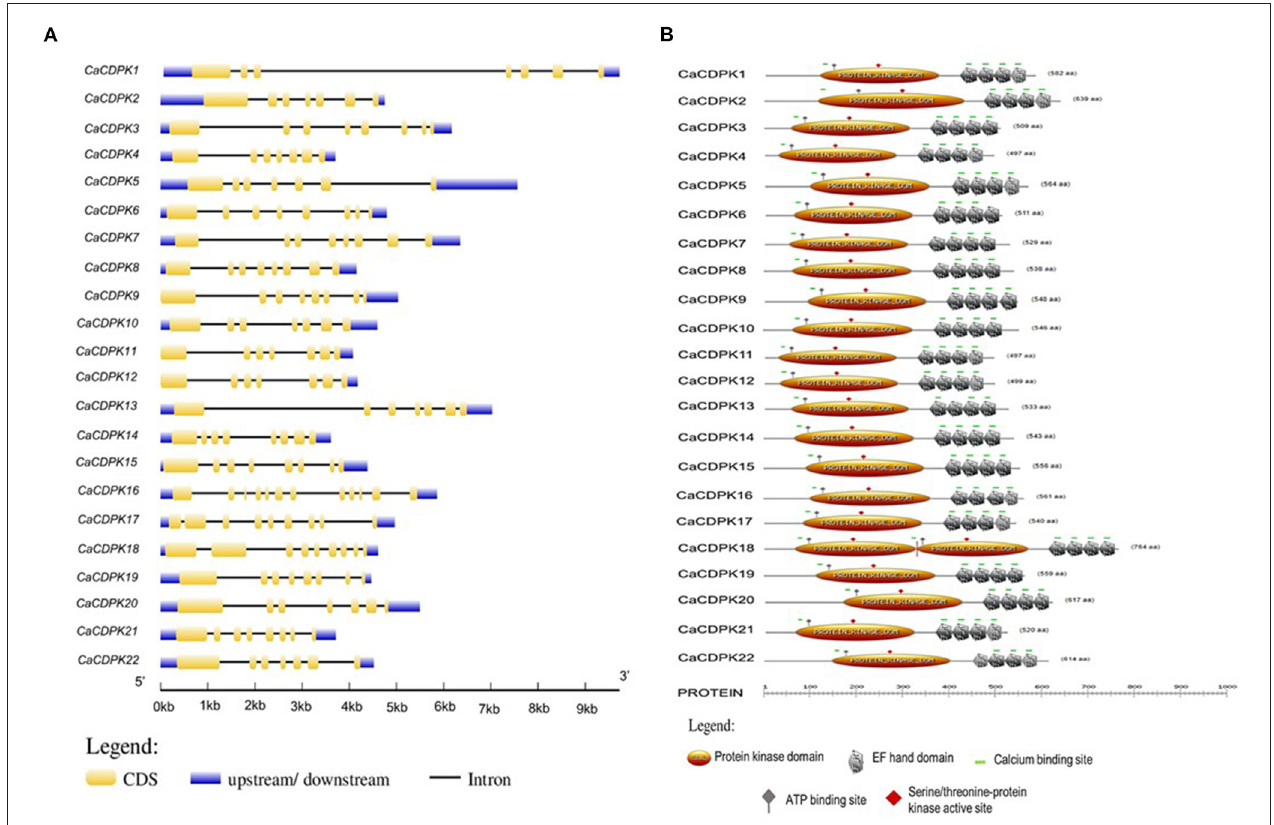
FIGURE 1 | Structural features of the chickpea calcium-dependent protein kinases (CDPK) family. (A) Exon-intron organization is shown for CaCDPK genes and gene names are mentioned at the left. The scale at the bottom represents gene length in kb. (B) Protein domain structure of the chickpea CDPK family is showing conserved protein kinase and EF-hand along with some important sites present. ATP binding site and Serine/threonine-protein kinase active site are located at the protein kinase